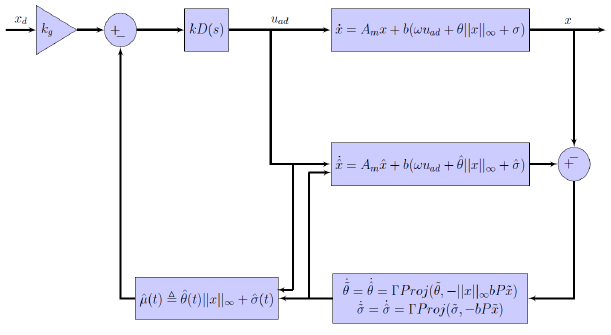
Figure 1. L 1 Adaptive